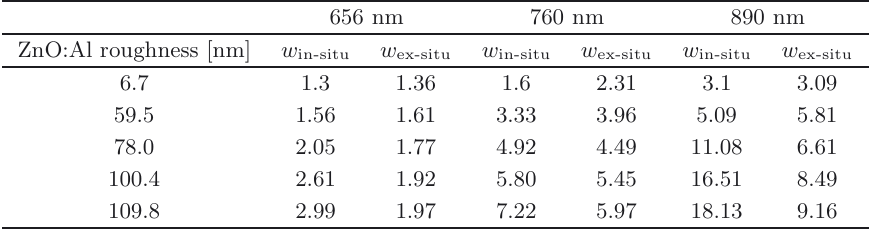
Table 1. Light path enhancement factors as function of ZnO:Al roughness. The light path enhancement factors of three different wavelengths (656 nm, 760 nm, 890 nm) were calculated from in-situ transmission measurements ( w in-situ ) and quantum efficiency measurements of the solar cells ( w ex-situ